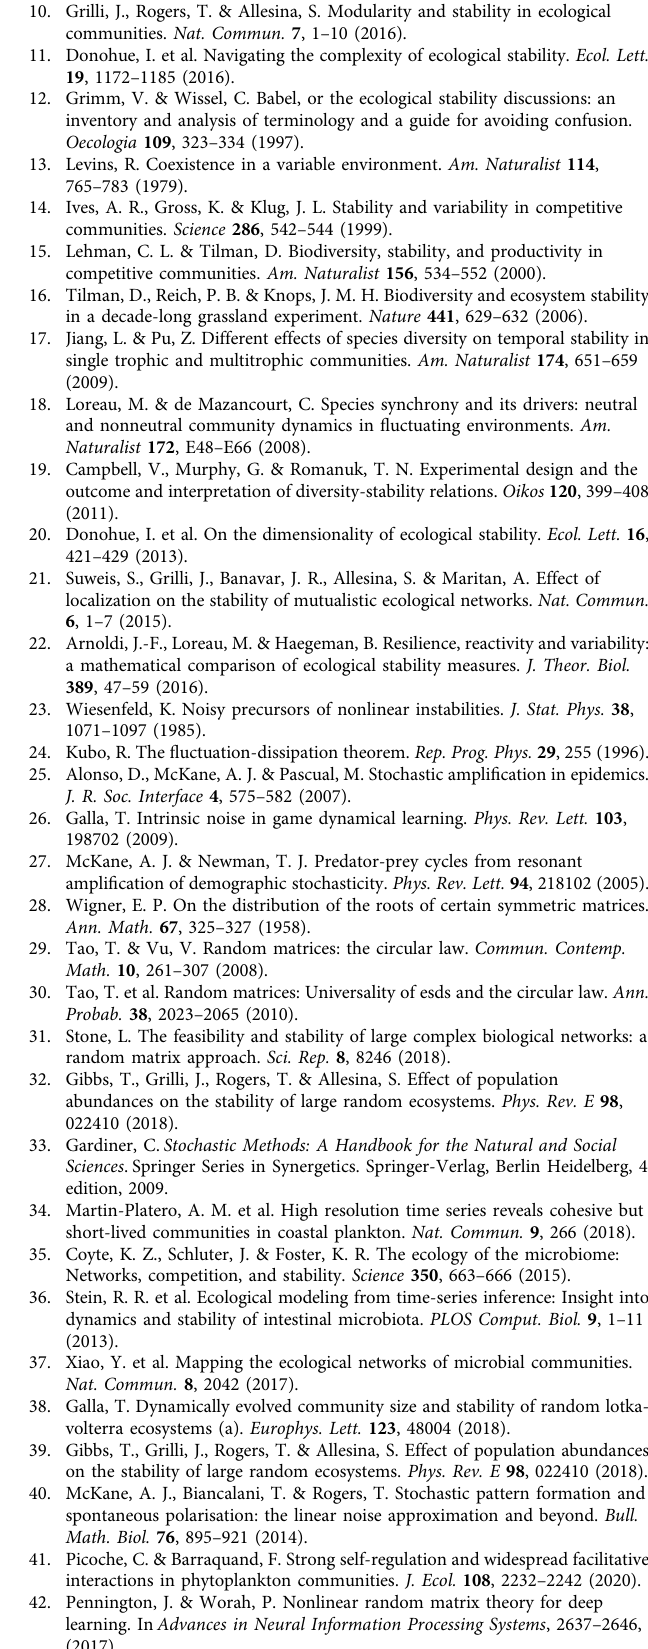
Figure details Figure 1, left panels . A large random Lotka-Volterra ecosystem of the type described above was generated. Parameters used were: N = 1000, c = 50, γ = − 1, σ 2 = 1/4/ c , b = 0.05. The solid line is the result of Eq. (6), noting that μ ¼